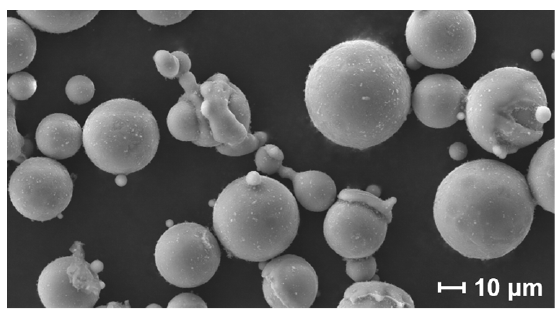
Figure 1. SEM image of magnesium alloy AZ91D powder. Table 1. Chemical composition of magnesium alloy AZ91D powder.